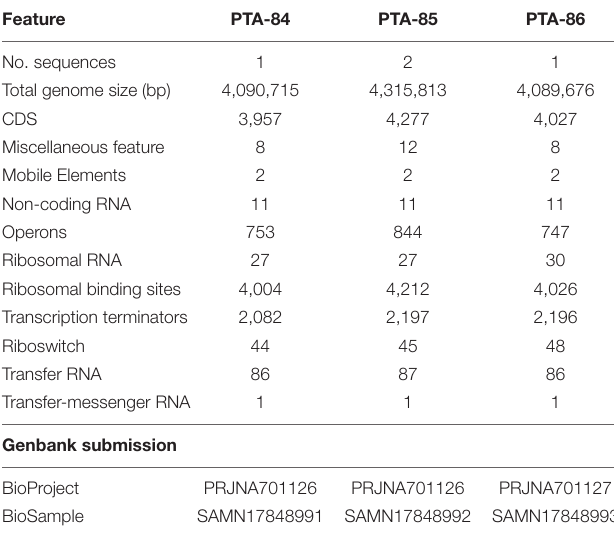
TABLE 1 | Genome assembly and annotation summary of Bacillus